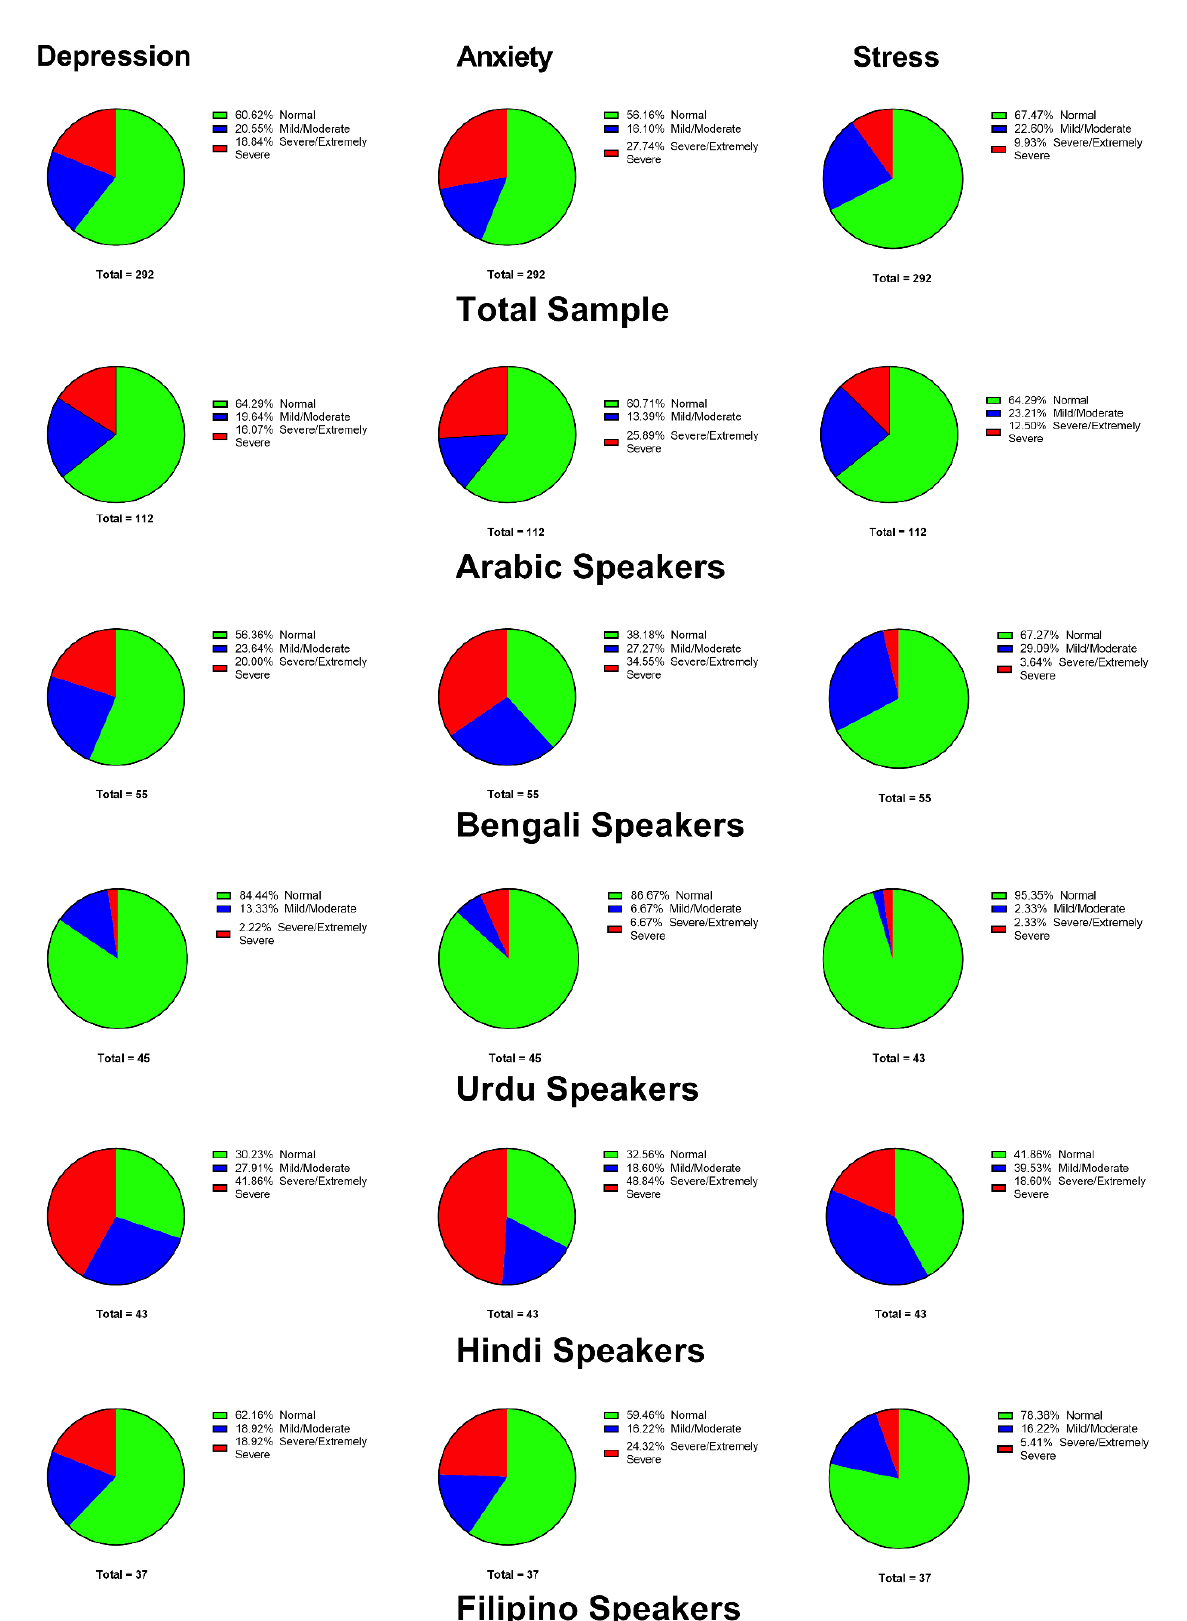
Figure 2. Prevalence and severity of psychological disorders by language spoken by participants.